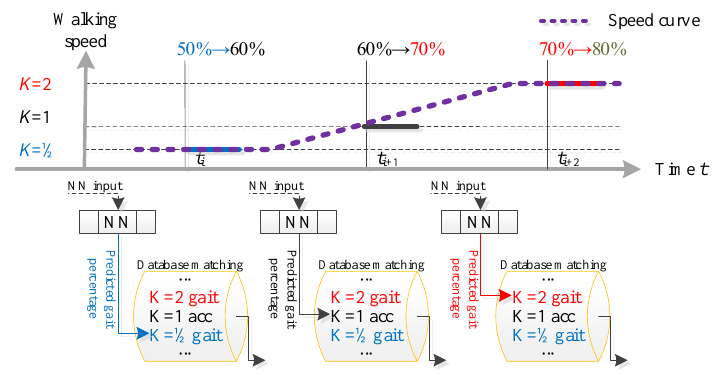
Figure 10. Typical operating state during control.